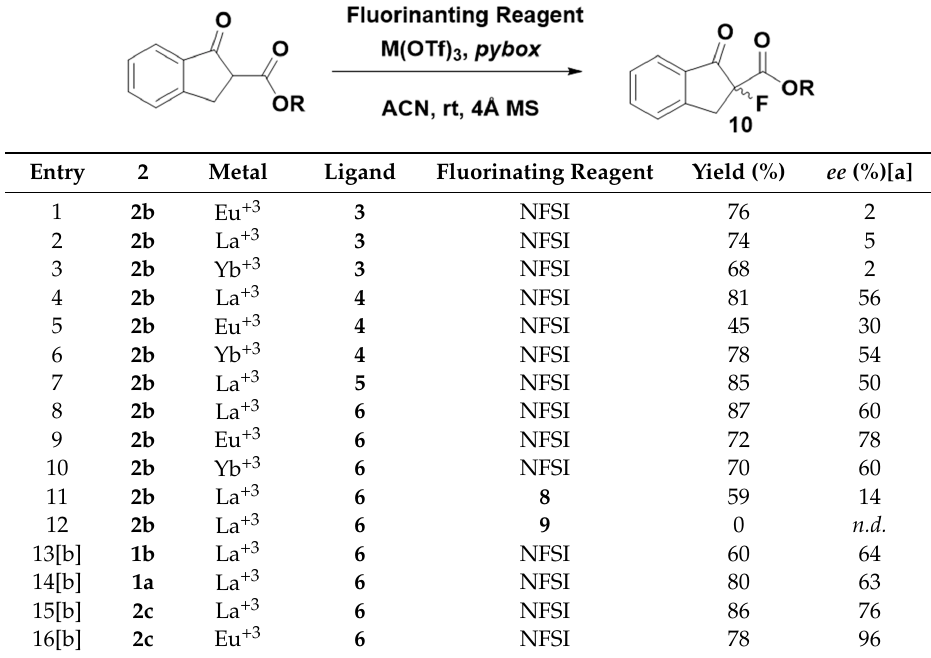
Figure 1. Fluorinating agents and pybox C2-symmetry ligands used in the optimization of the electrophilic enantioselective fluorination reaction.